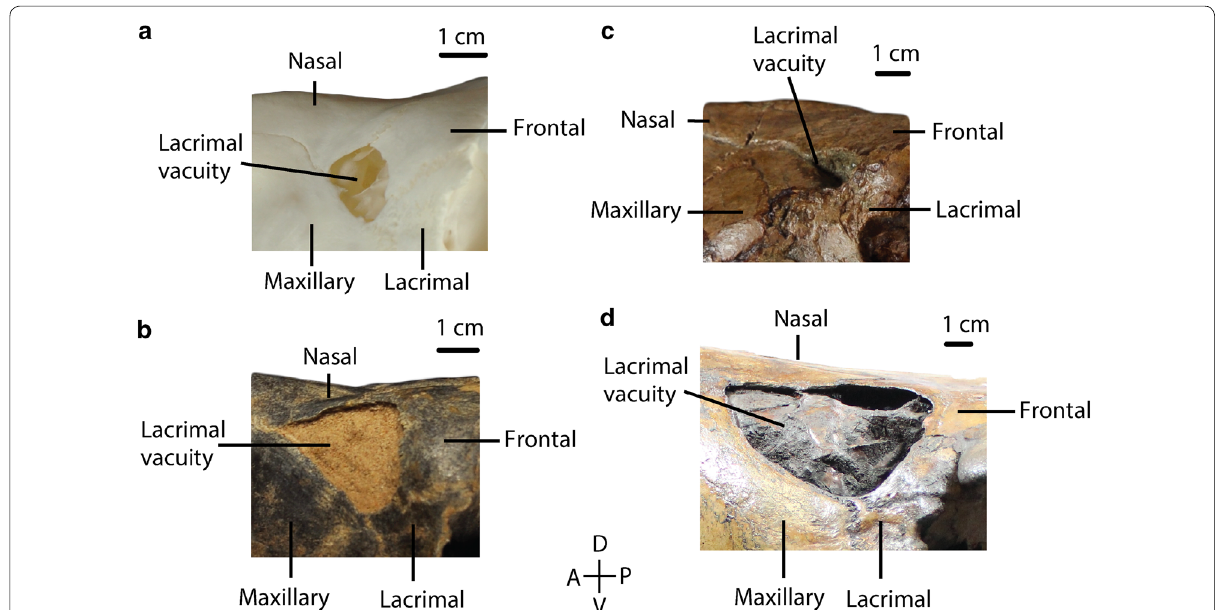
Fig. 6 Char. 25: Bones bordering the lacrimal vacuity. a L. guanicoe (ZM 17,209), left side, scored small, bordered by four bones (frontal, maxillary, lacrimal, nasal) (1) b P. vera (AMNH 24,670), left side, scored large, bordered by four bones (frontal, maxillary, lacrimal, nasal) (0). c A. alexandrae (UCMP 26,015), left side, scored bordered by three bones (frontal, maxillary, and lacrimal) (3). d C. hesternus (UCMP 20,040), left side, scored bordered by four bones (frontal, maxillary, lacrimal, and nasal), lacrimal border greatly reduced, frontal border greatly enlarged